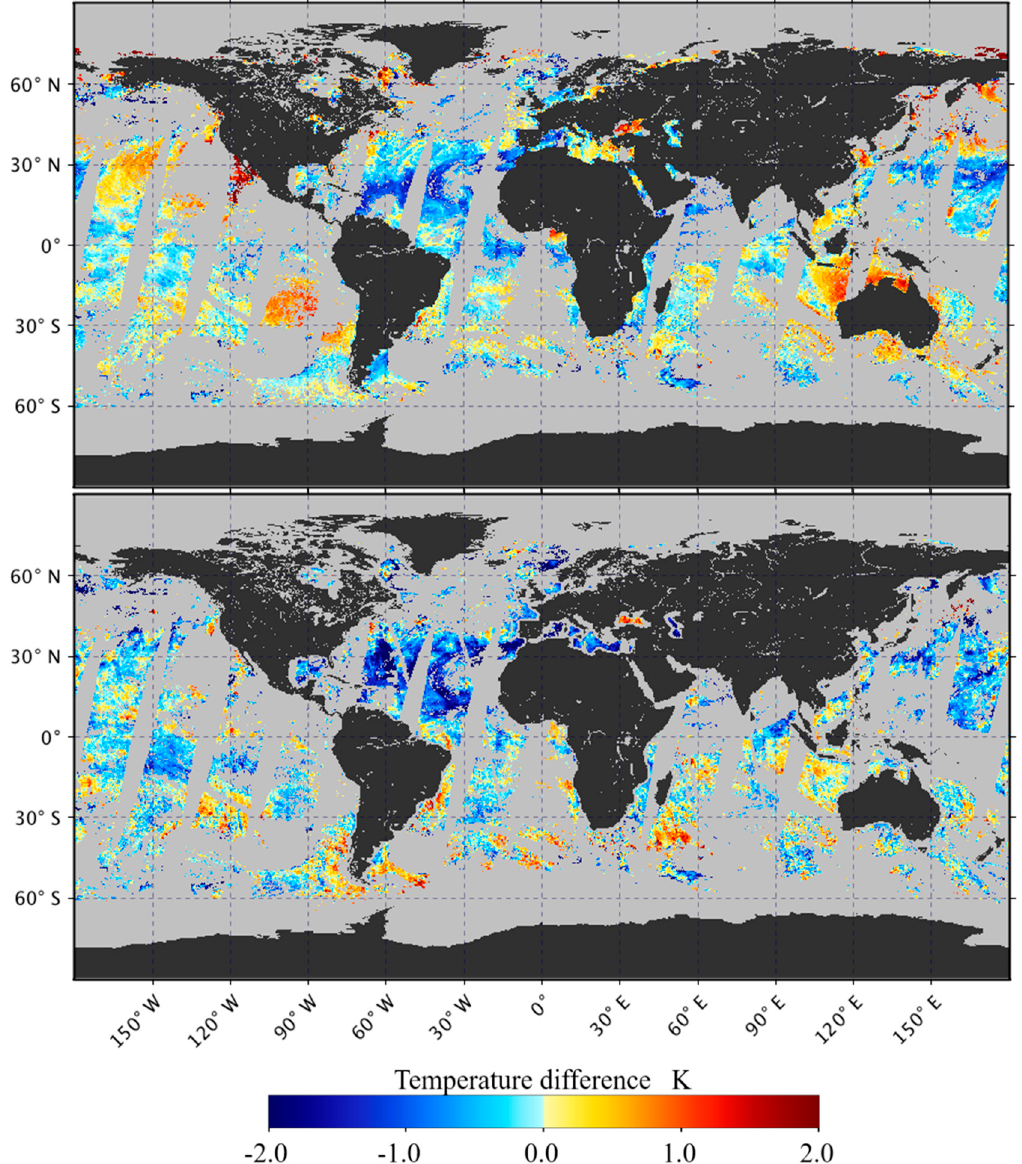
Figure9. Anexampleofthenightdi ff erencebetween3-bandVIIRSskinSST triple (Equation(4))andDaily Figure 9. An example of the night difference between 3-band VIIRS skin SST triple (Equation (4)) and Optimally Interpolated SST (DOISST) best quality data for August 12th 2012 ( top ) and compared to Daily Optimally Interpolated SST (DOISST) best quality data for August 12th 2012 (top) and WindSat microwave SST ( bottom ). The color scale is ± 2 K. Black indicates land and grey corresponds compared to WindSat microwave SST (bottom). The color scale is ±2 K. Black indicates land and grey to clouds or no corresponds to clouds or no data.